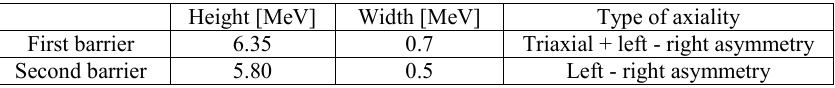
Table 1. First and second barriers